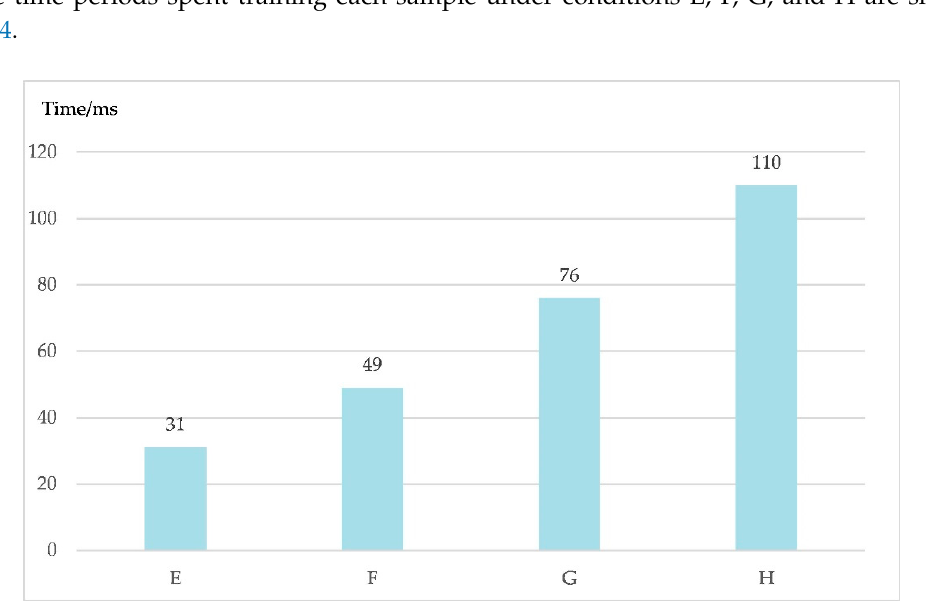
Figure 14. Time periods spent training each sample with different convolution kernel sizes of (3, 3), (5, 5), (7, 7), and (9, 9), expressed as E, F, G, and H, respectively.